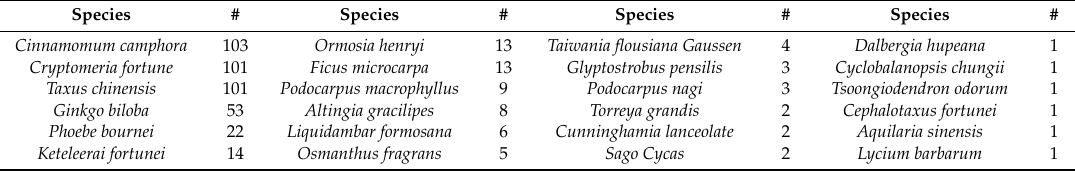
Table 2. Common ancient trees in Youxi County (unit = a plant or a